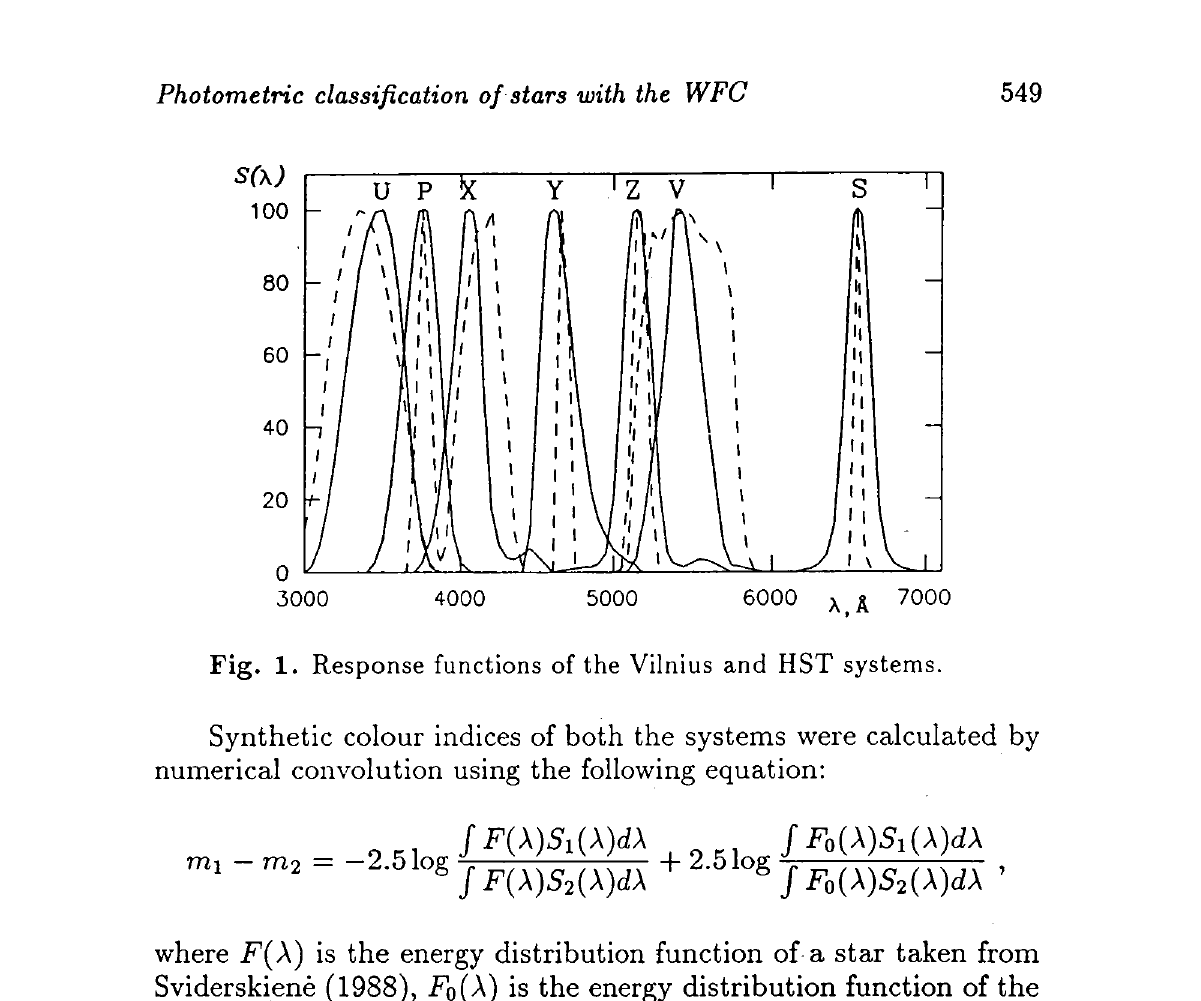
Fig. 1. Response functions of the Vilnius and HST